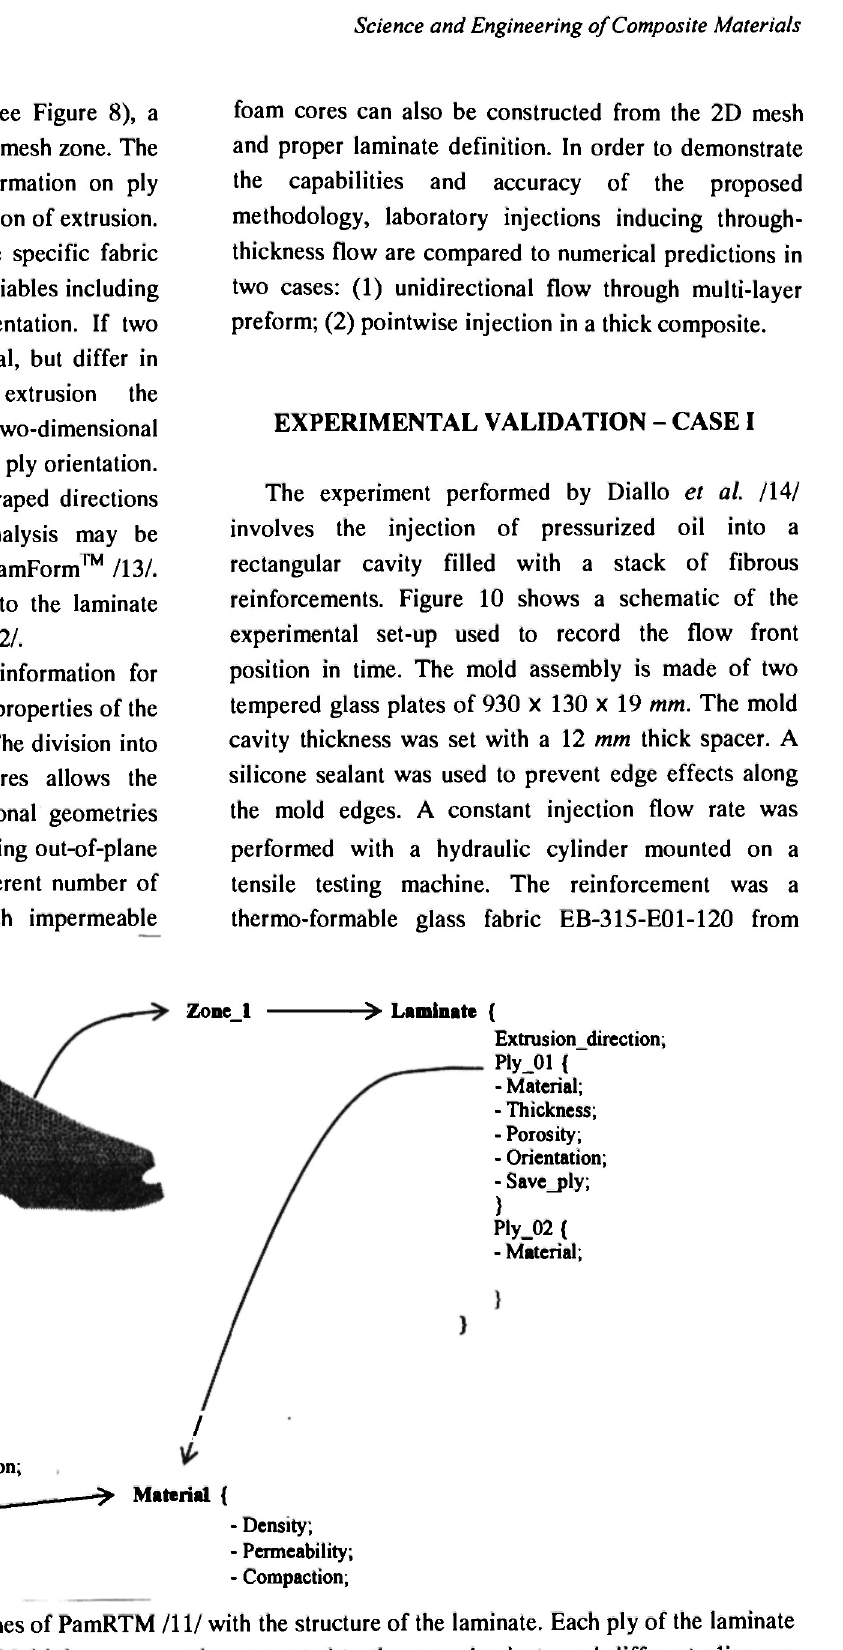
Fig. 8: Data structure used to relate zones of PamRTM / l l/ with the structure of the laminate. Each ply of the laminate is related to a fabric material. Multiple zones can be connected to the same laminate and different plies can point to the same